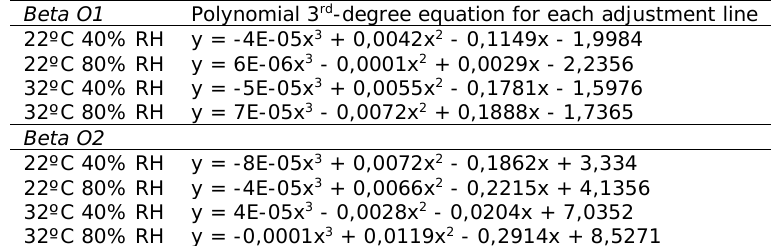
Table 3. Polynomial 3rd degree fitted models (Beta O1 waves and Beta O2